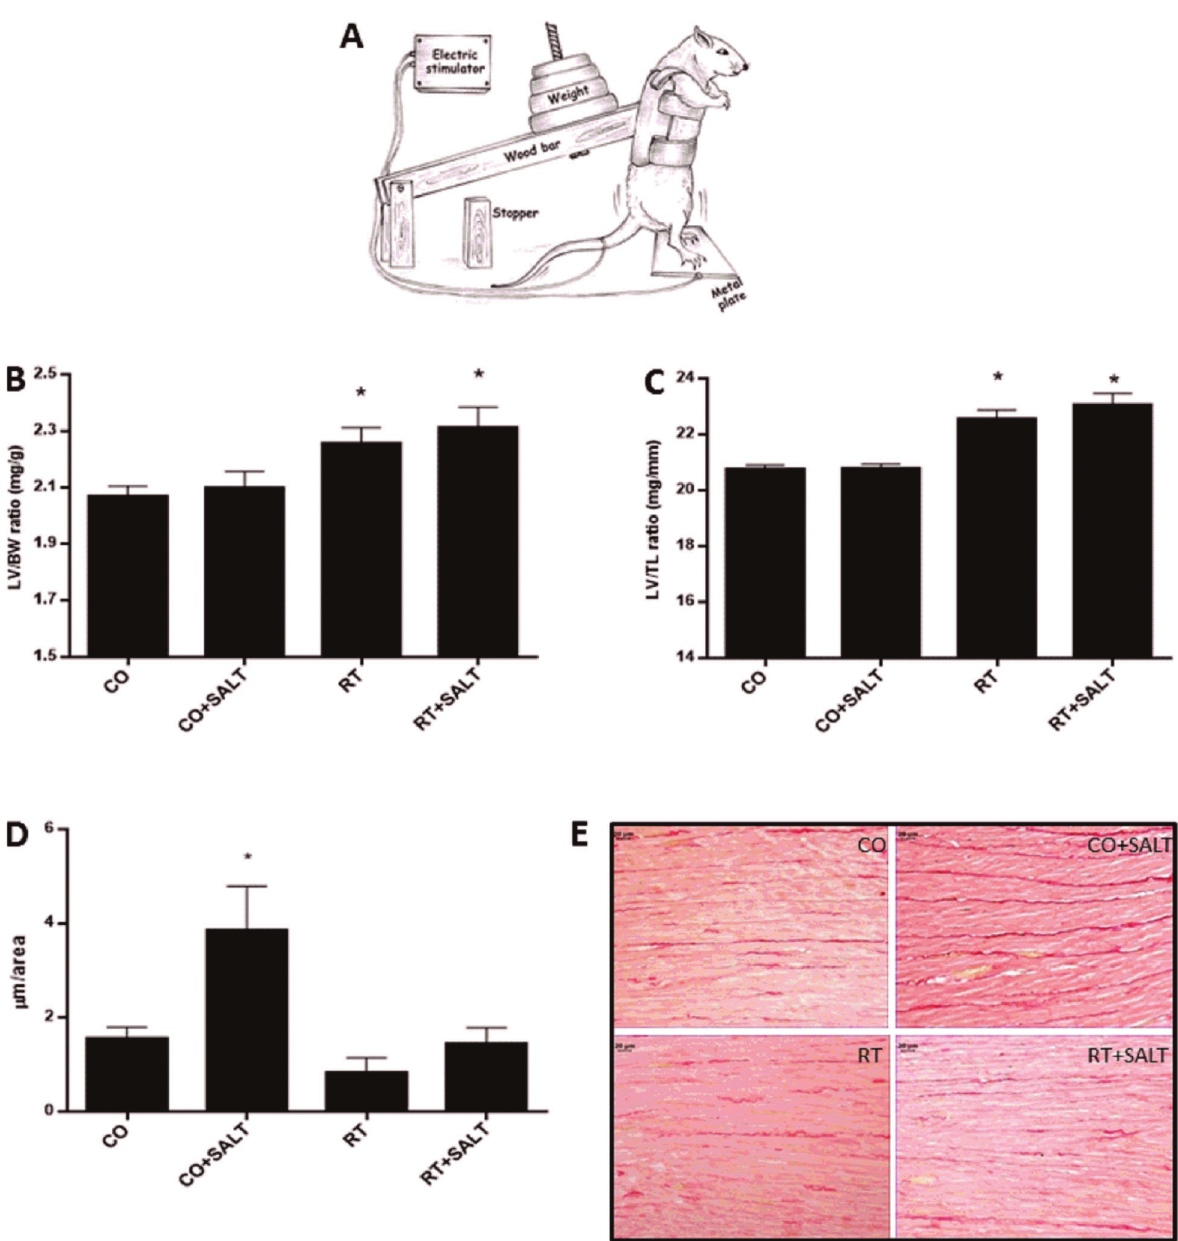
Figure 1. A , Apparatus used to perform resistance training in the rats adapted from Tamaki et al. (10); B , left ventricle (LV) weight-to- body weight (LV/BW) ratio (mg/g); C , LV weight-to-tibia length (LV/TL) ratio (mg/mm); D , myocardial interstitial collagen volume fraction; E , representative images of the collagen fi bers stained with picro-sirius red in the myocardium. Data are reported as means ± SE for 8 rats in each group. CO: control; CO + SALT: control + 1% salt diet; RT: resistance trained; RT + SALT: resistance trained + 1% salt diet. *P o 0.05 vs CO and CO + SALT. For all variables, one-way ANOVA followed by Duncan post hoc test was